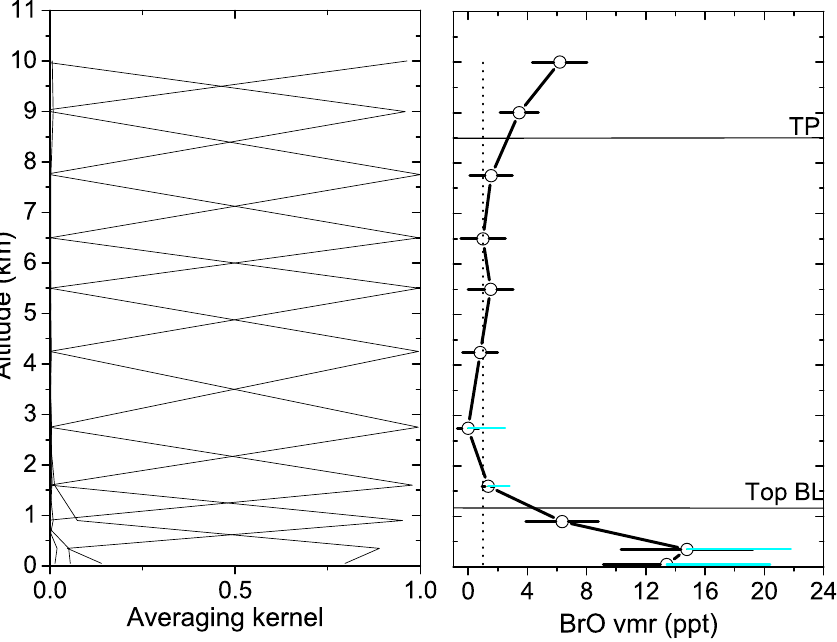
Fig. 8. Retrieval of the BrO vertical profile. Left: averaging kernel profile indicating 10 degrees of freedom. Right: BrO mixing ratio vertical profile. The black error bars include the retrieval noise and the uncertainty in forward RT model parameters such as the aerosol load and the ground albedo. The cyan error bars include biases in the error estimation if BrO horizontal gradients within each modeled atmospheric layer were present during the time of the measurements. The dashed vertical line indicates the BrO detection limit.